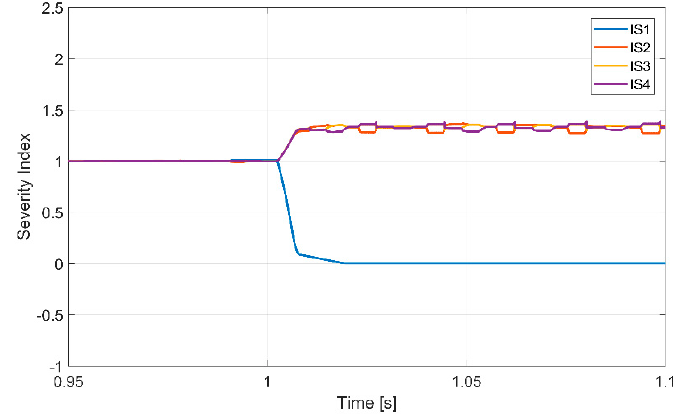
Figure 9. Diagnostic variables associated with the motor winding currents of the SRM at 600 rpm in normal condition and open-circuit failure of power device S 1 A (simulation result).